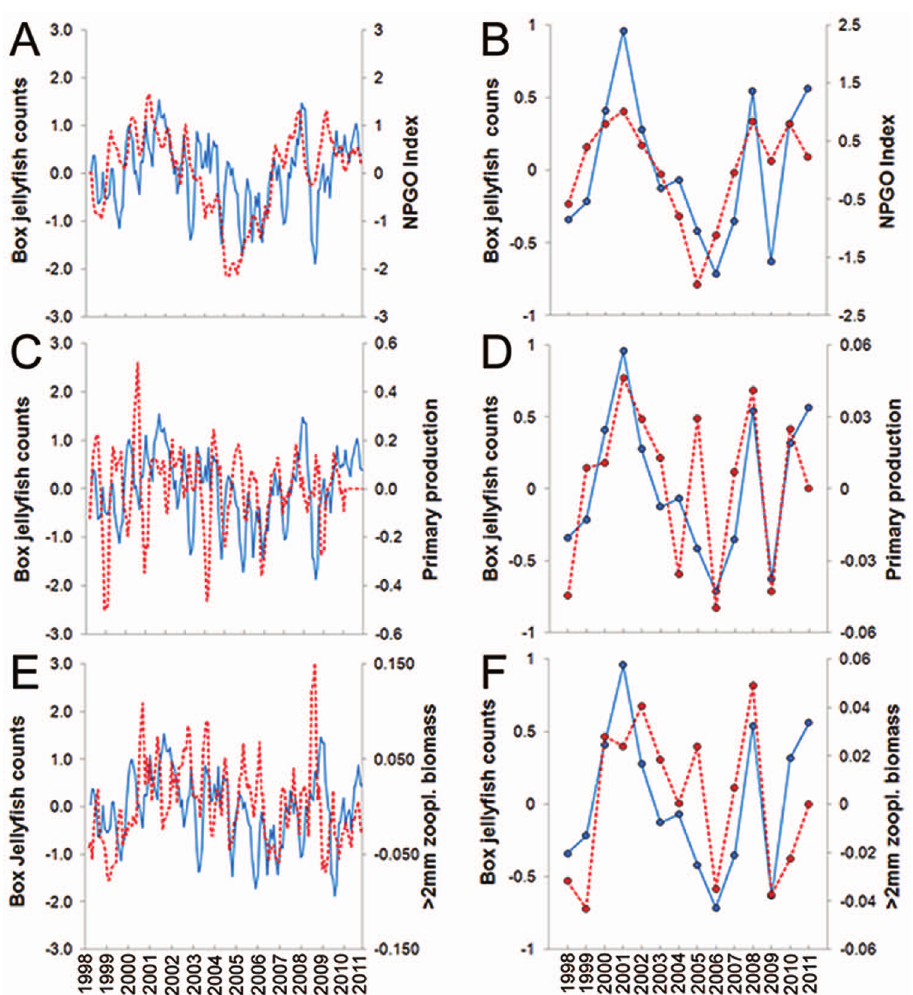
Figure 4. Time-series of climatic and biogeochemical variables with box jellyfish beach counts at Waikiki. Log-transformed, detrended variables are shown, Y-axes are residual values. Graphs A, C, and E represent monthly time-series (three-month average smoothing), while graphs B, D, and F represent annual means. Solid blue lines represent box jellyfish numbers, dashed red lines represent climate and biogeochemical variables, including NPGO (A, B), primary production (C, D), and zooplankton biomass (E, F). Note different scale in the Y-axis of variables between monthly and annual analyses. Error bars were not included in order to enhance visualization. Biogeochemical variables were obtained at Station ALOHA, from the Hawaiian Oceanographic Time-series program (HOT) at